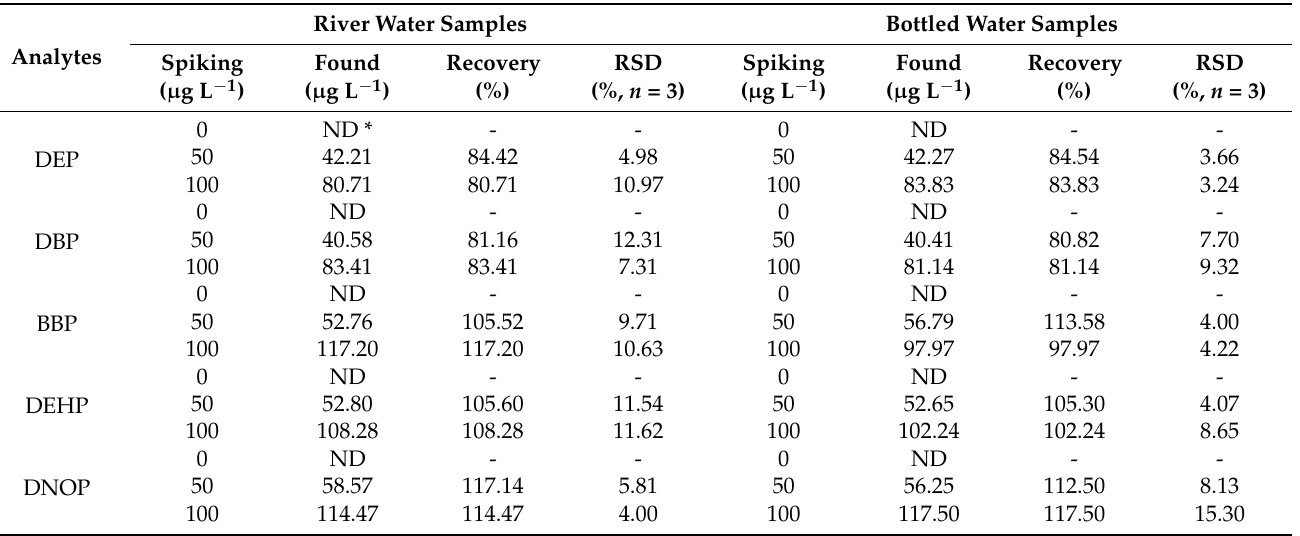
Table 2. Analytical results for the determination of five PAEs compounds in Huajing River and bottled water